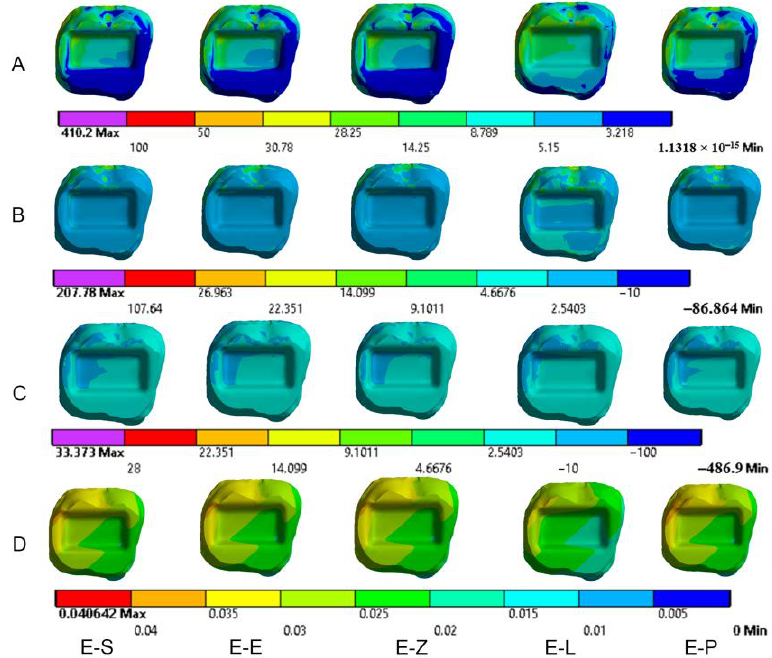
Figure 10. Stress distribution and displacement of dentin in all models under axial loading. ( A ) von Mises stress, ( B ) maximum principal stress, ( C ) minimum principal stress and ( D ) displacement. E-S: zirconia-reinforced lithium silicate ceramic model, E-E: lithium disilicate glass ceramic model, E-Z: translucent zirconia model, E-L: resin nanoceramic model and E-P: polymer-infiltrated ceramic network model.